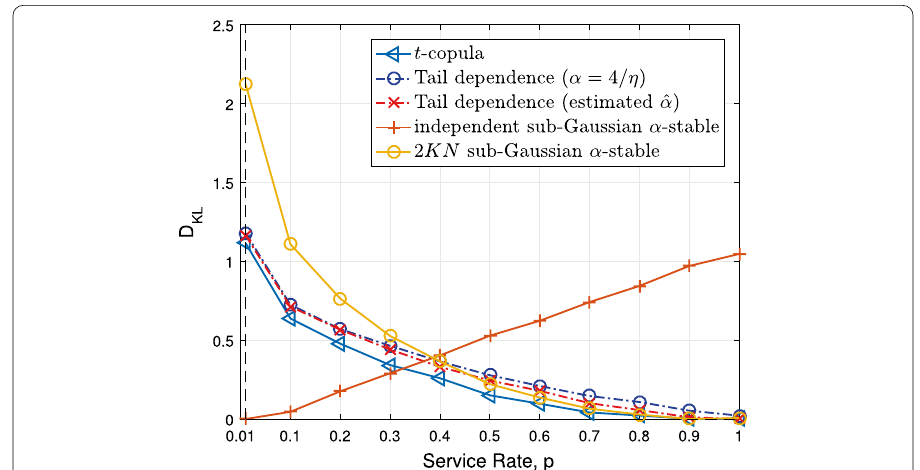
Fig. 6 Plot of the KL divergence between the simulated data set and five statistical models (under doubly Poisson cluster process): t ‑copula model (maximum likelihood); Algorithm 1 based on α = 4 /η ; Algorithm 1 based on estimated ˆ α ; independent sub‑Gaussian α ‑stable model; and 4 K sub‑Gaussian α ‑stable model. In the figure, K = 4 msBs and N = 2 subcarriers in each msB are considered